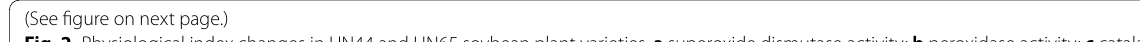
(See figure on next page.) Fig. 2 Physiological index changes in HN44 and HN65 soybean plant varieties. a superoxide dismutase activity; b peroxidase activity; c catalase activity; d soluble sugar content; e soluble protein content; f malondialdehyde content; g proline